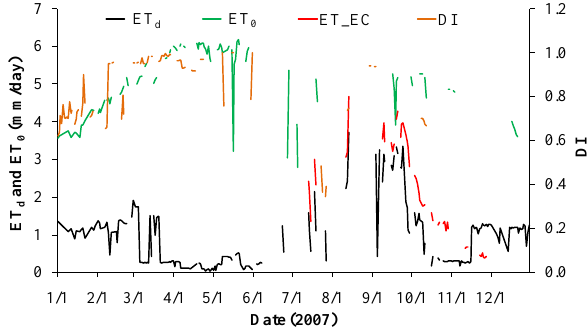
Fig. 4. Time series of estimated actual daily ET (ET d ), estimated reference daily ET (ET 0 ), eddy covariance-based observed ET (ET_EC), and estimated dryness index (DI) at the SD-Dem site in 2007.